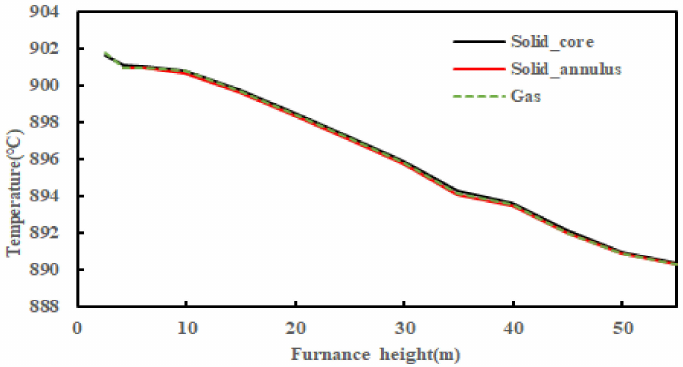
Figure 9. The temperature distribution of solid and gas in the